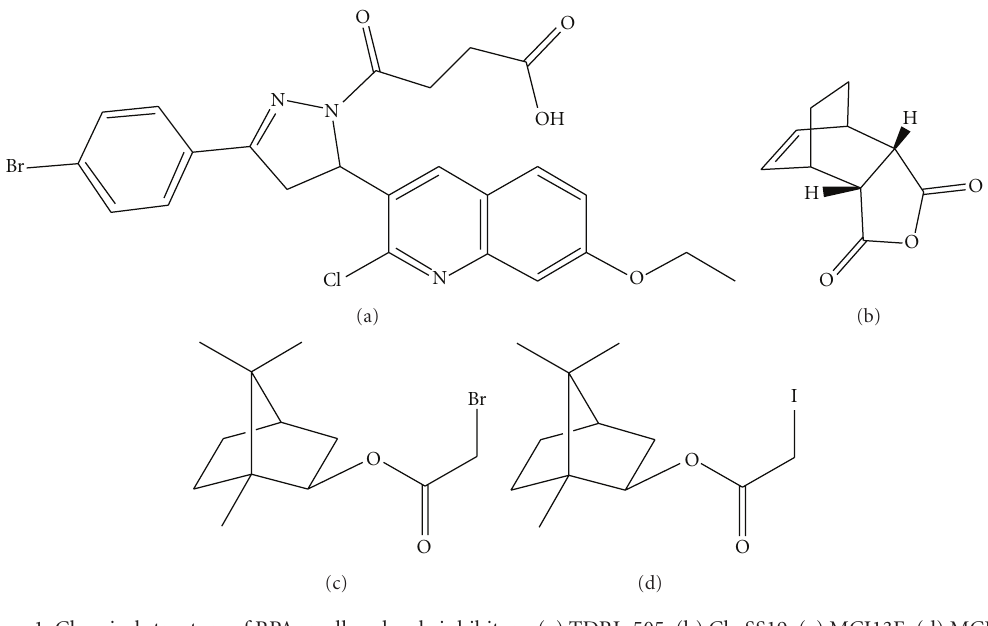
Figure 1: Chemical structure of RPA small molecule inhibitors. (a) TDRL-505; (b) CheSS19; (c) MCI13E; (d) MCI13F.